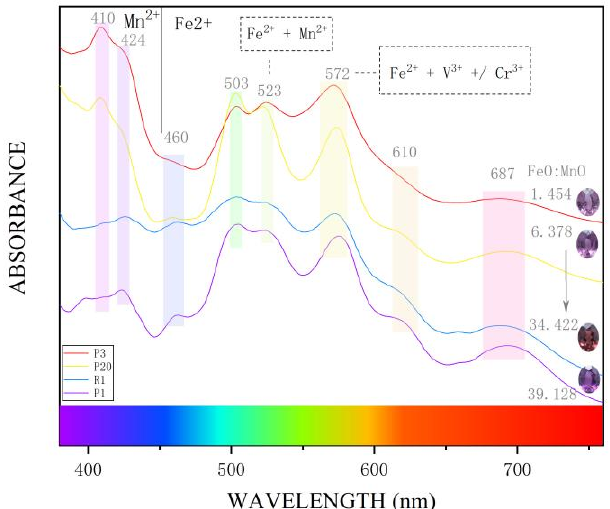
Figure 4. Absorption spectra of four faceted pyrope-almandine shows systematic variations according to their iron and manganese contents. The color varies from light violet (at lower FeO:MnO ratios) to purplish red (at higher FeO:MnO ratios), and alters to fancy violet ultimately (at highest FeO:MnO ratios). The sample P3 and P20 are similar with both relatively medium iron contents, but the rest samples show similar absorption features with different color.